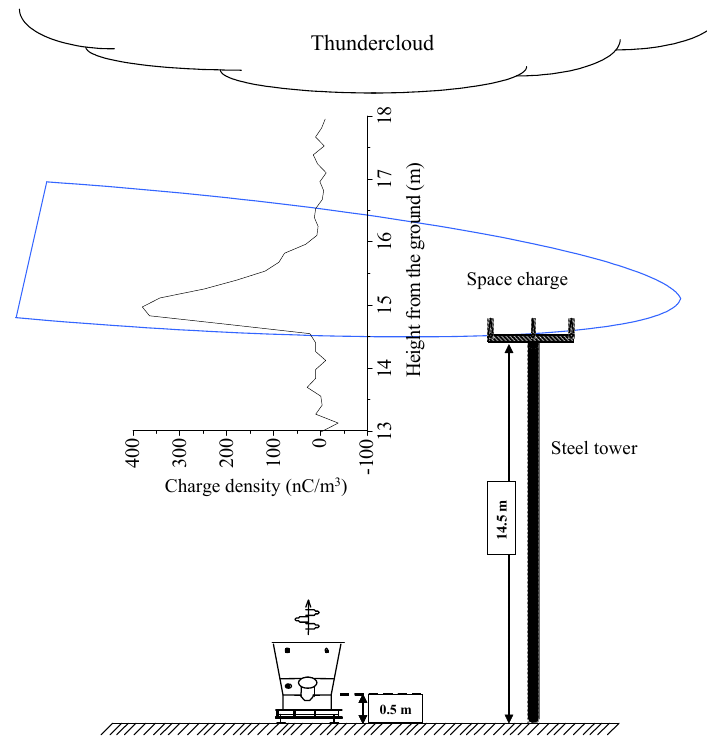
Figure 8 . An example result measured in field with the developed